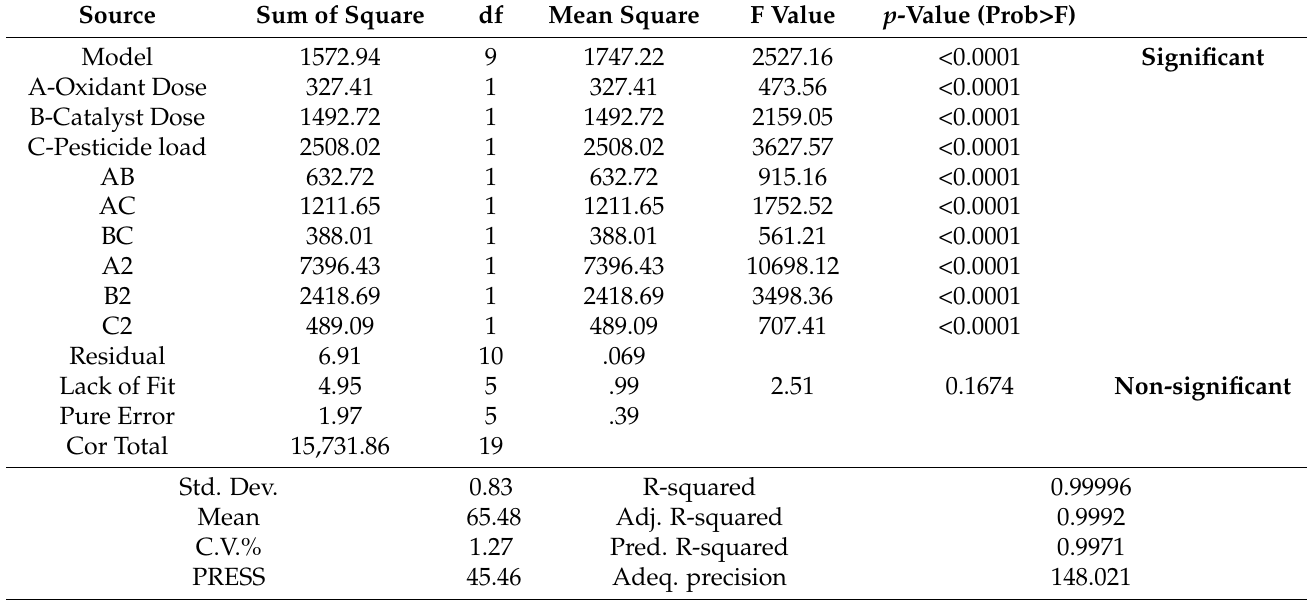
Table 3. ANOVA results of the quadratic model for degradation of acetamiprid using GO-Fe 3 O 4 .